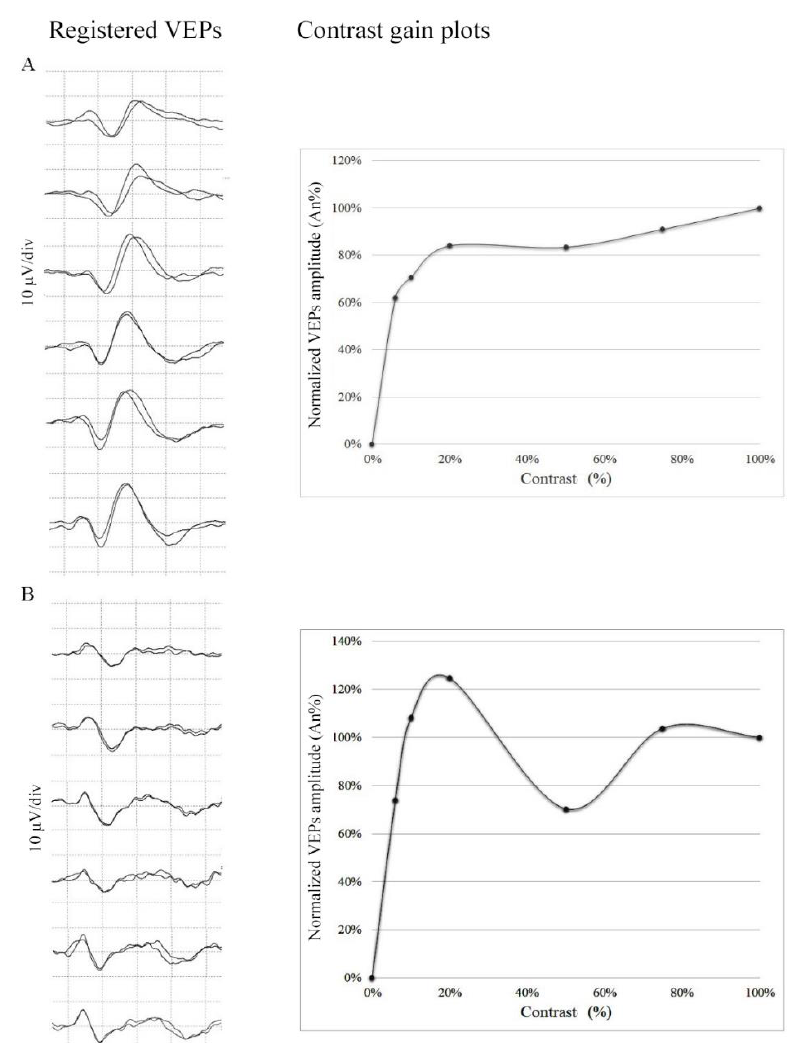
Figure 3. Graphic plotting of VEP amplitude to contrast gain: ( A ) control subject with normal saturation at maximum contrast (S = 1) and ( B ) a migraine patient with supersaturation (S = 0.80). The left column shows the signal registered for each subject at different contrasts (6%, 10%, 20%, 50%, 75%, and 100%) (50 ms horizontal divisions and 10 µV vertical divisions). The right column visualizes the plots of normalized amplitude (considering VEP amplitude registered at the contrast of 100%). The examples were chosen to visualize how different individuals could show signal amplitudes not comparable in terms of raw microvolts. The normalization is indeed necessary to compare the results avoiding misleading interindividual differences.